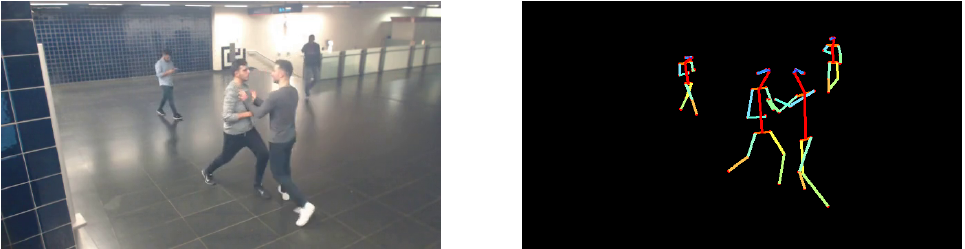
Figure 5. Multi-person pose estimation example using DensePose [63] from the Detectron2 framework [64].